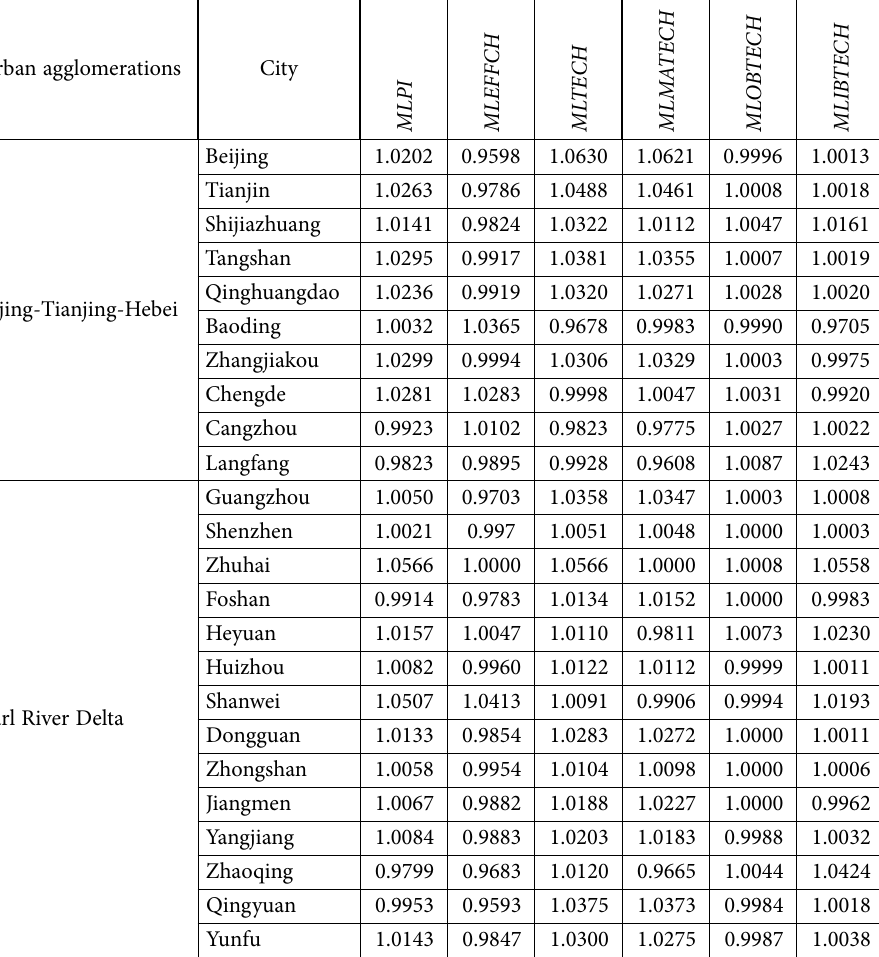
Table A1. Total Factor Productivity Index and its decomposition of each city